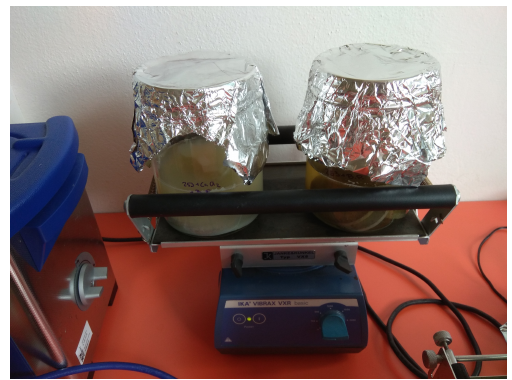
Figure 4. Concrete specimens in media (253 media on the left, 253 media with 2% CaCl right).